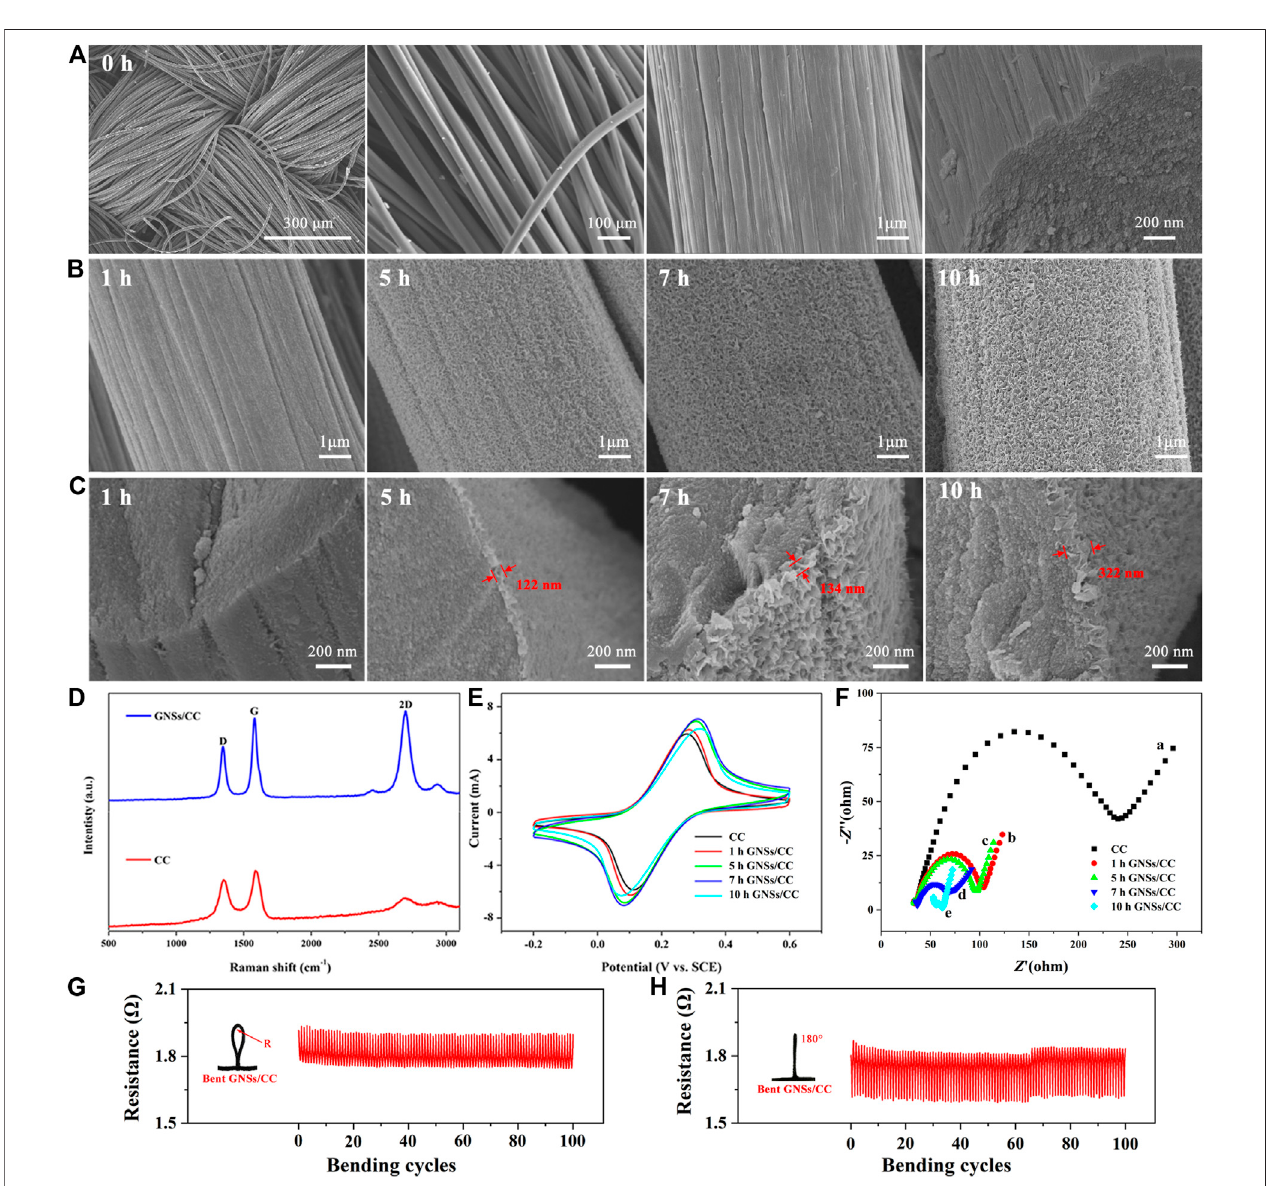
FIGURE2| RelevantcharacterizationofCCandGNSs/CC. (A) SEMofCCmorphologyanditscrosssection. (B) SEMofGNSs/CCwithdifferentgrowthperiodsof GN. (C) SEM of GNSs/CC cross sections with different growth periods. (D) Raman spectra of CC and GNSs/CC. (E) Cyclic voltammograms of CC and GNSs/CC. (F) EISofdifferentelectrodesin0.01 mM[Fe(CN) 6 ] 3-/4- and0.1 MKClsolutions. (G) ResistanceoftheGNSs/CC fl exiblesensorbentfor100timesataradiusR (cid:2) 3 mm. (H) Resistance of the GNSs/CC fl exible sensor bent for 100 times at 180 °